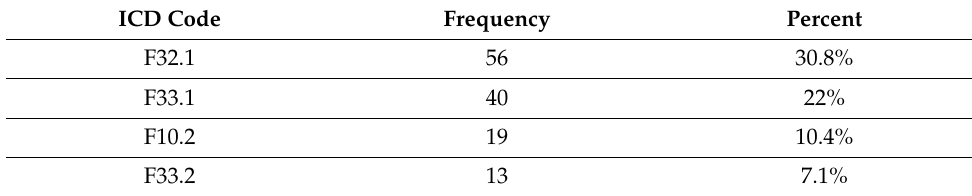
Table 1. Frequencies of ICD Codes in the foehn group.